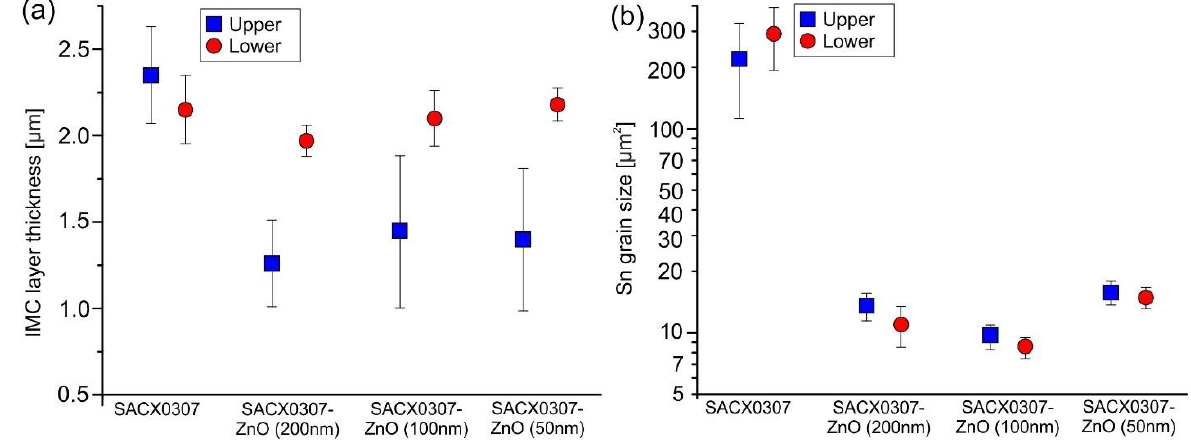
Figure 8. Microstructural Results 1: ( a ) average IMC thicknesses; ( b ) average Sn grain sizes. The addition of ZnO ceramic into the SACX0307 solder alloy resulted in refinement of the Sn grains in each case, from ~200–300 µ m 2 to ~10–15 µ m 2 . No significant differences were found between the composite solders, and the Sn grain refinement did not depend on the ZnO particle size in the range investigated (50–200 nm). The Sn grain boundaries are marked by red dashed lines according to the Ag 3 Sn network in the Sn matrix (Figure 9). The ZnO particles promoted a high nucleation density in the second phase in the eutectic colony during solidification.